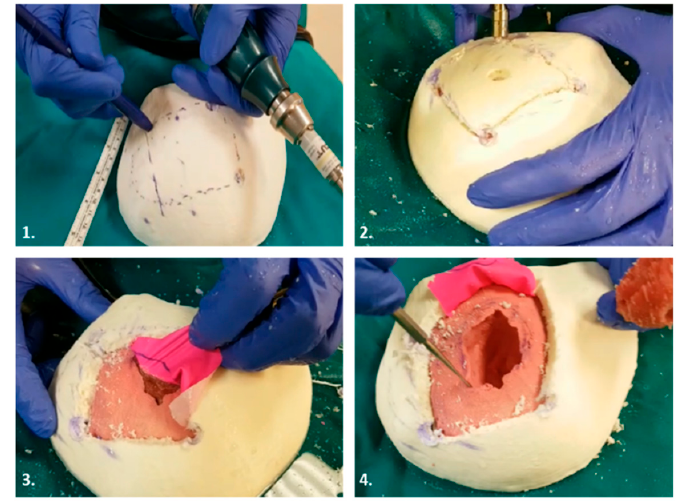
Figure 6. Simulation of the surgical procedure. 1 . Skull flap tracking with surgical skin marker pens; 2 . Craniotomy; 3 . Separation of meninges from meningioma tumors; 4 . Meningioma removal.